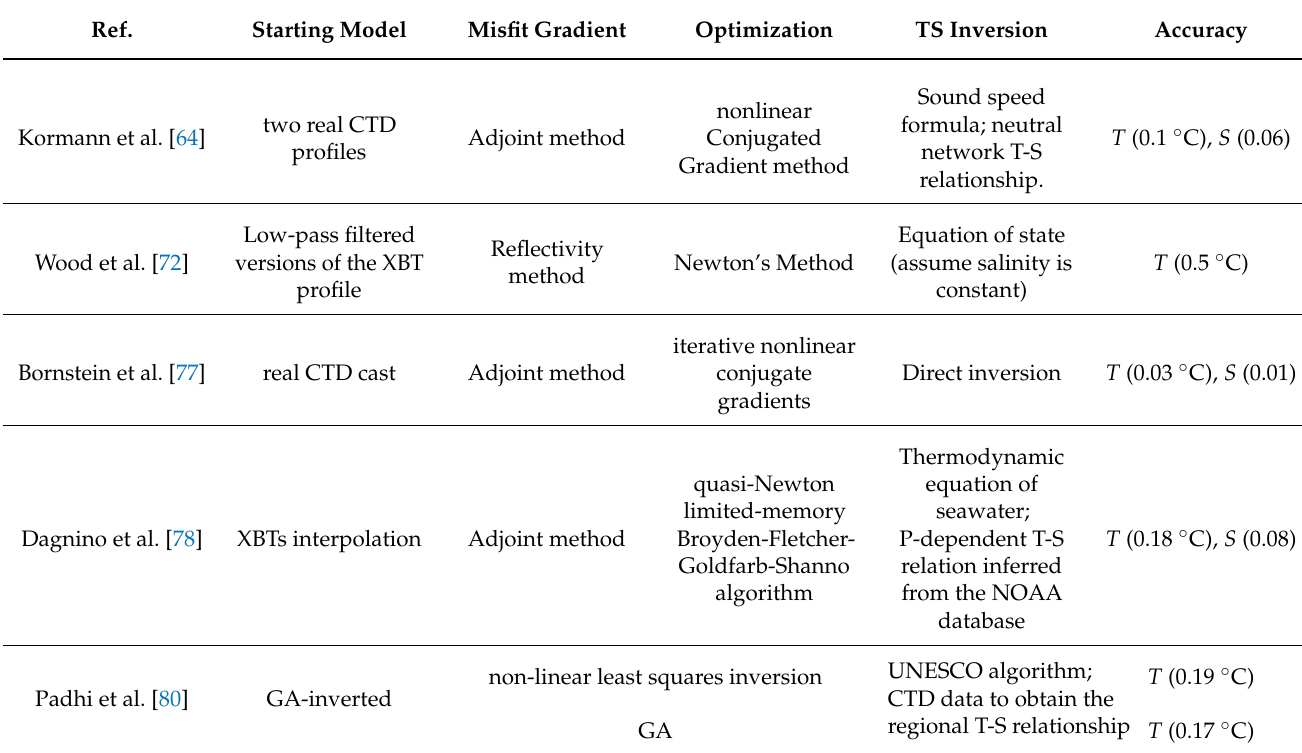
Table 5. The comparison of different FWI